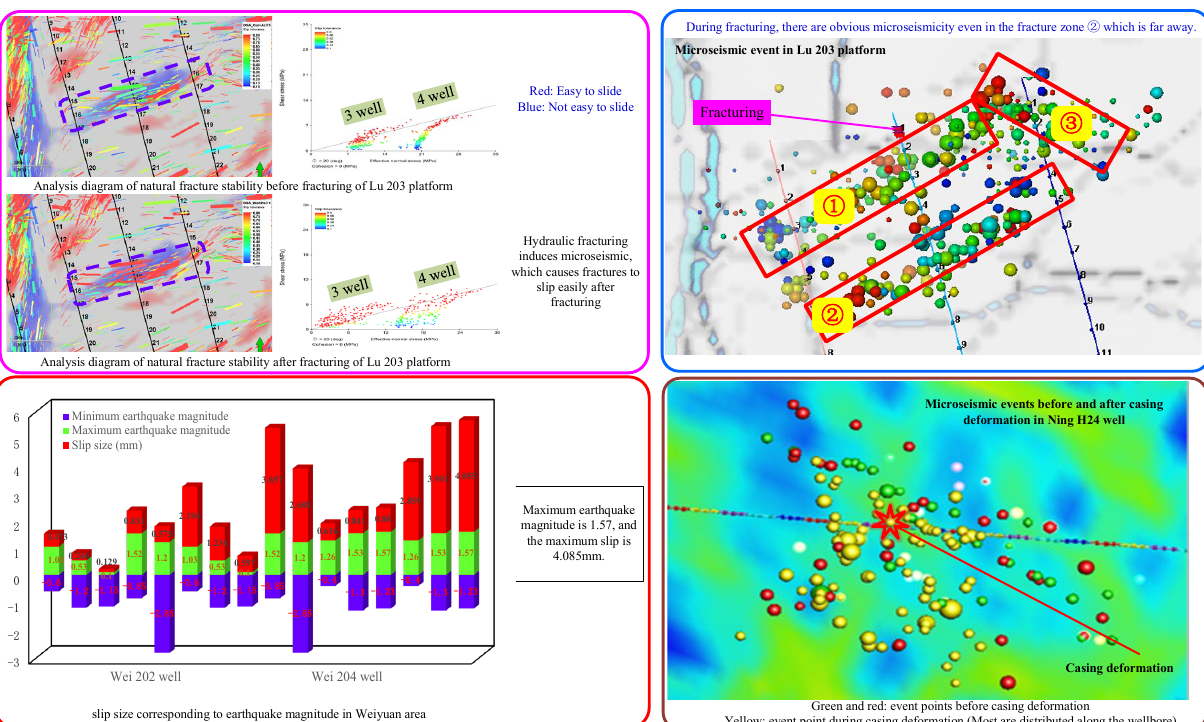
Green and red: event points before casing deformation Yellow: event point during casing deformation (Most are distributed along the wellbore) Figure 4. Microseismic events and their effects before and after fracturing in different blocks.